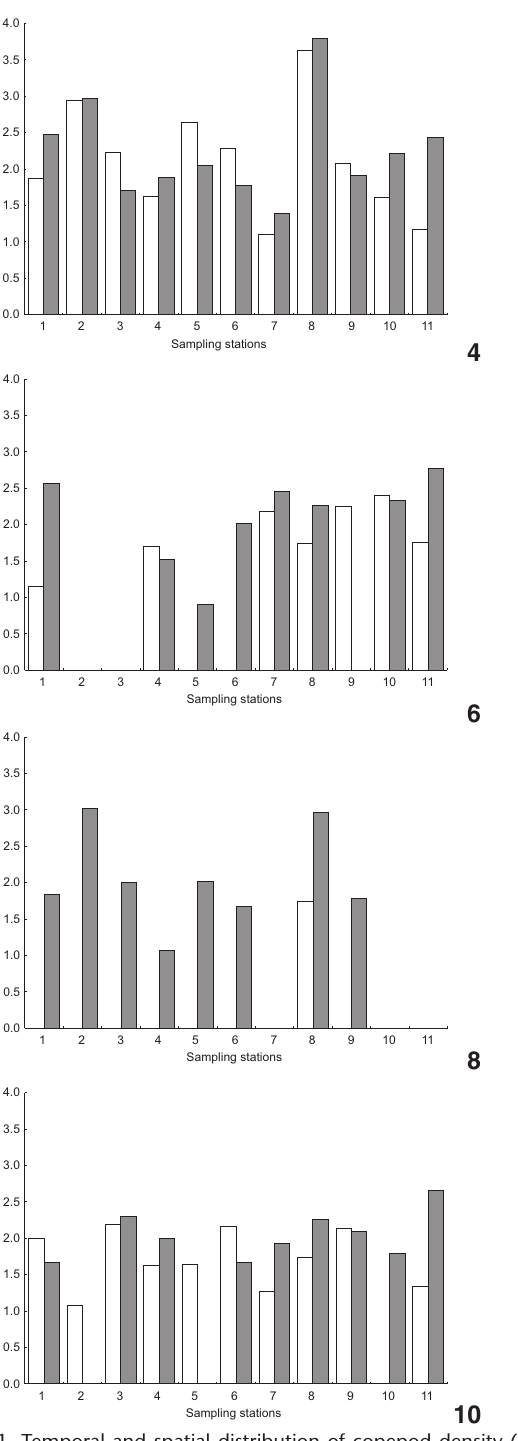
Figures 4-11. Temporal and spatial distribution of copepod density (ind.m -3 ) of the dominant species of copepods on the inner shelf adjacent to the coastal system of Camamu Bay: (4) P. quasimodo ; (5) S. pileatus ; (6) C. furcatus ; (7) C. giesbrechti ; (8) T. turbinata ; (9) O. similis ; (10) T. stylifera ; (11) N. minor . ( (cid:2) ) Wet season; January 2004, ( (cid:3) ) dry season, August